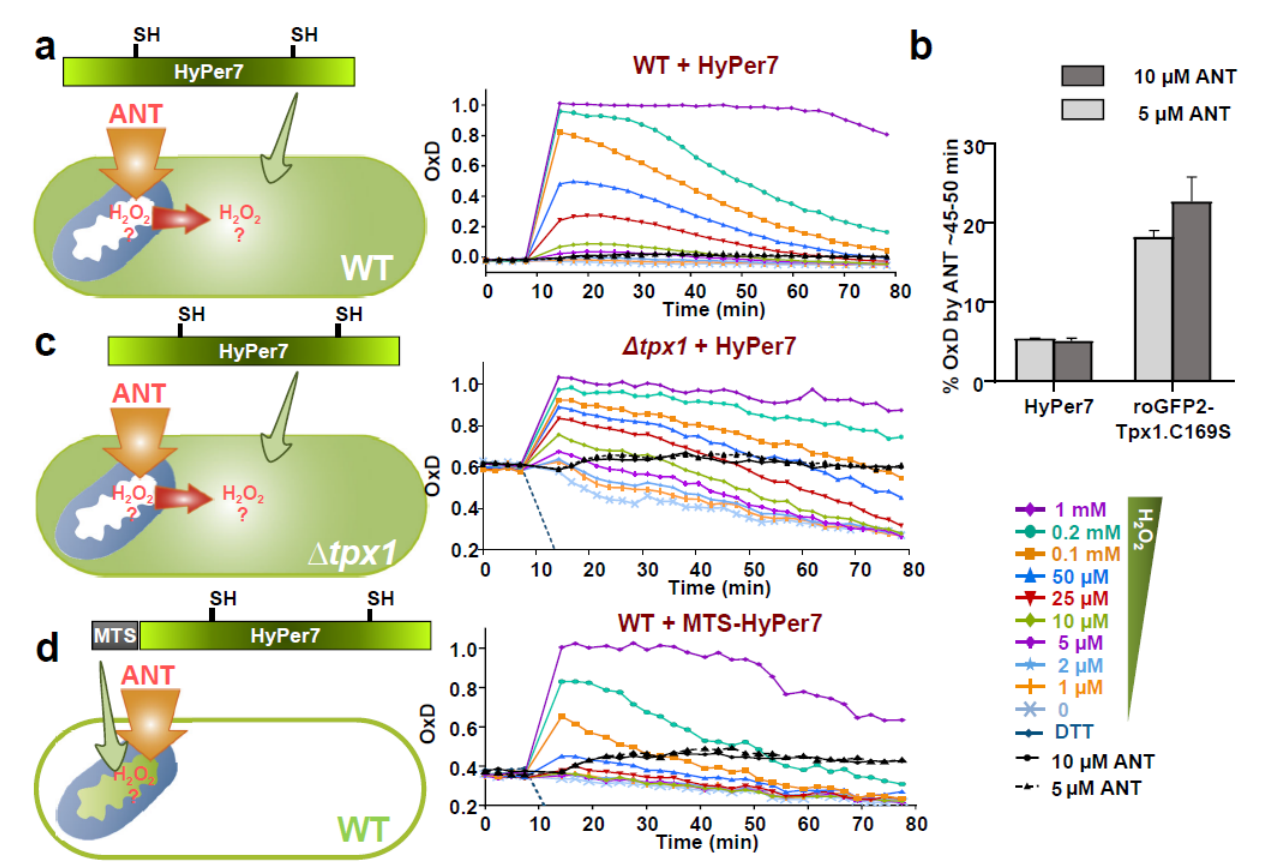
Figure 5. Detection of H 2 O 2 produced at the mitochondria upon ANT treatment can be detected by MTS-HyPer7 but not by cytosolic HyPer7 unless the H 2 O 2 scavenger Tpx1 is absent. ( a ) The indicated concentrations of H 2 O 2 or ANT were directly added to MM cultures of strain HM123 + p728 (WT + HyPer7), and oxidation of the reporter was estimated as described in Figure 1; oxidations upon ANT treatments are represented with solid (10 μM ANT) or dashed (5 μM ANT) black lines. Average data from three biological replicates are shown, with error bars (S.D.) displayed in Figure S5. ( b ) Percentages of oxidation of the reporters HyPer7 and roGFP2-Tpx1.C169S upon ANT treatment were determined as described in Figure 1d between 45 and 50 min, from experiments of Figure 5a (HyPer7) and Figure S5d (roGFP2-Tpx1.C169S). ( c , d ) Cultures of strains SG5 + p728 (∆ tpx1 + HyPer7), ( c ) and HM123 + p730 (WT + MTS-HyPer7) ( d ) were treated and analyzed as in ( a ).